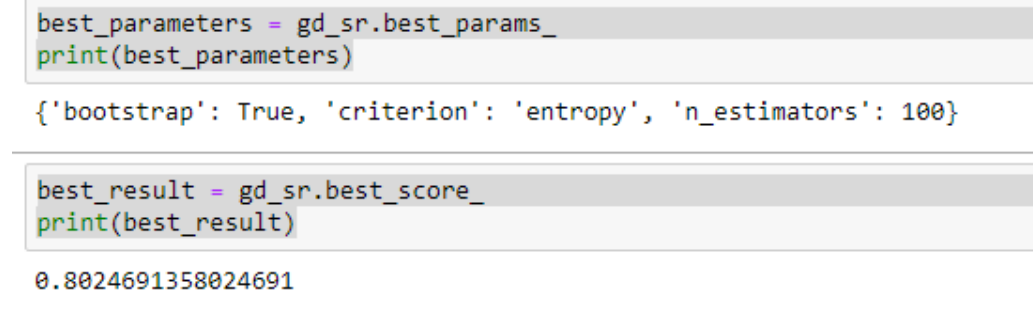
Figure 19. The accuracies achieved by the Folds after performing 10-Fold Cross-Validation on the RF model.